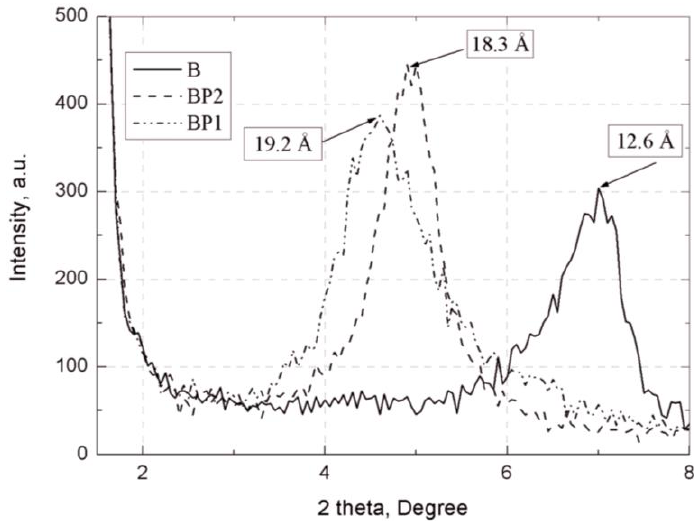
Figure 4. WAXS curves: unmodified bentonite (B) and samples BP1 and BP2 (d expressed in Å.